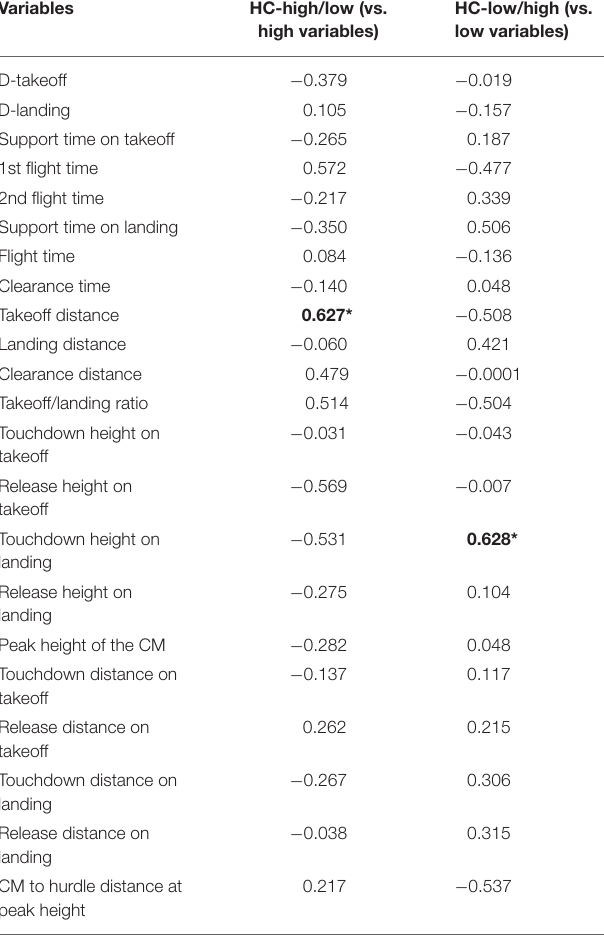
TABLE 3 | Relationship of HC-high/low and HC-low/high with each variable. Variables HC-high/low (vs. high